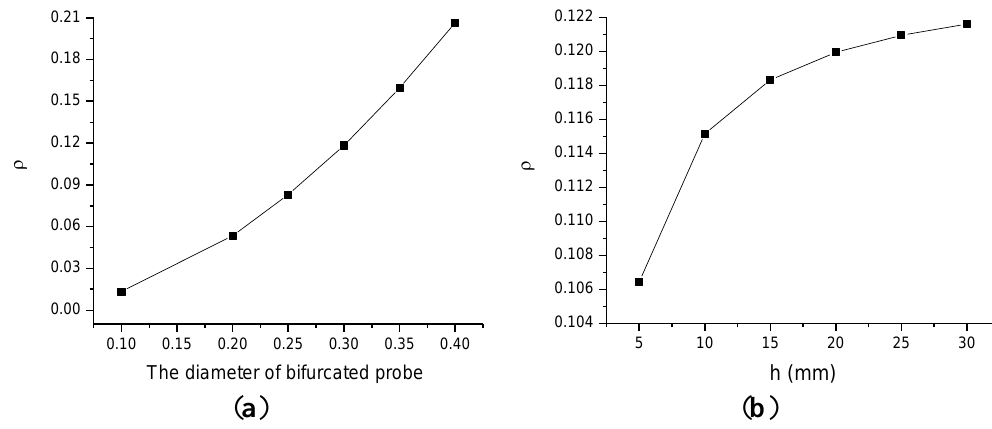
Figure 3. ( a ) Effect of the diameter of bifurcated probe on the fluorescence intensity ratio ρ. The distance between bifurcated/presented probe and sample is the same; ( b ) Effect of the distance between the end surface of the bifurcated probe and the fluorescence detection area on the fluorescence intensity ratio ρ